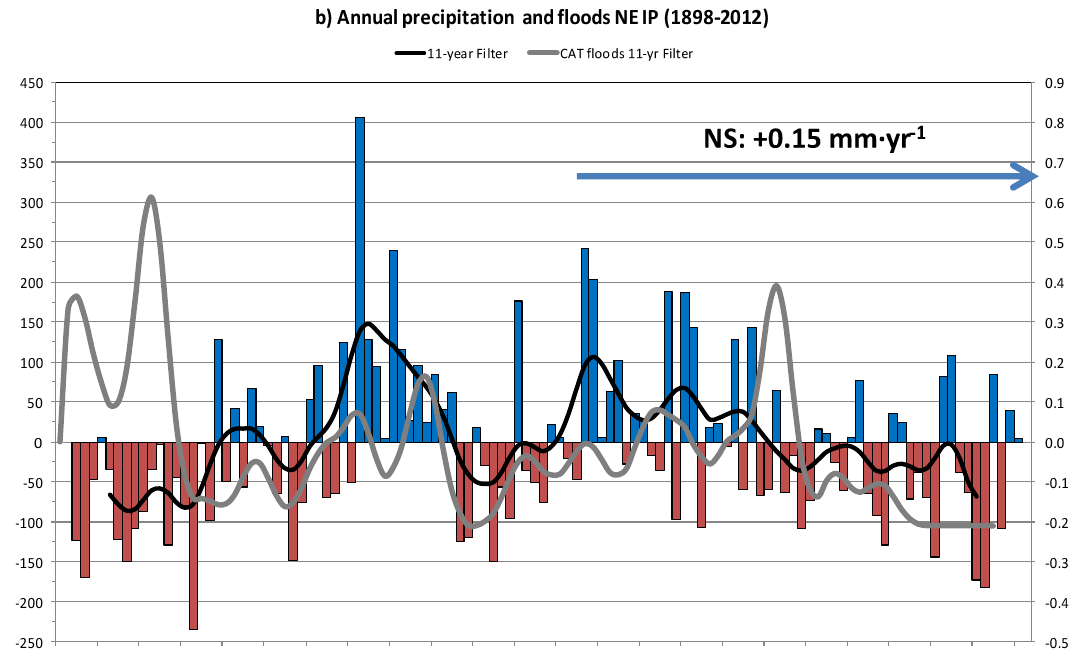
www.hydrol-earth-syst-sci.net/19/465/2015/ Hydrol. Earth Syst. Sci., 19, 465–483,